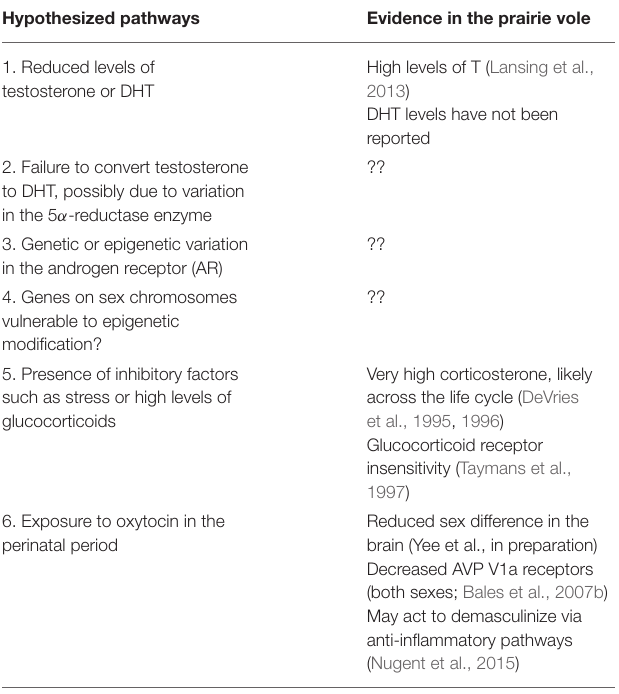
TABLE 4 | Putative pathways to reductions in physical sexual dimorphism and reduced “Masculine” traits. Hypothesized pathways Evidence in the prairie